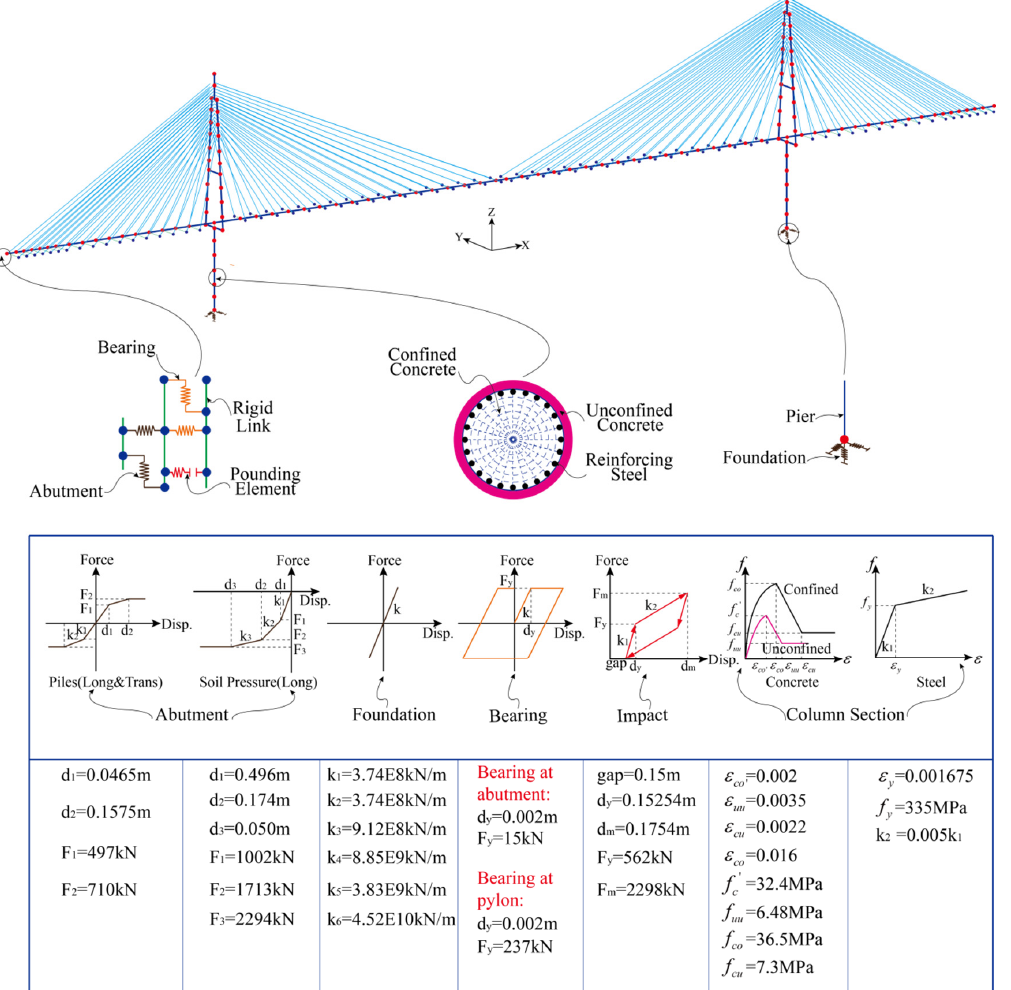
Figure 2. Analytical model of the prototype bridge. Table 1. Sectional properties of the bridge deck.